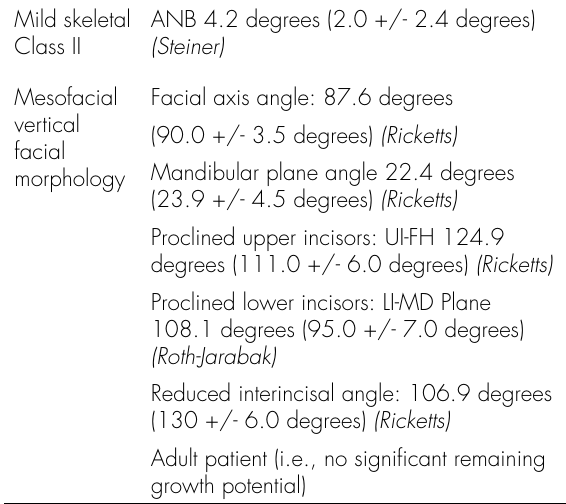
Table II. Cephalometric analysis – summary data (norms and standard